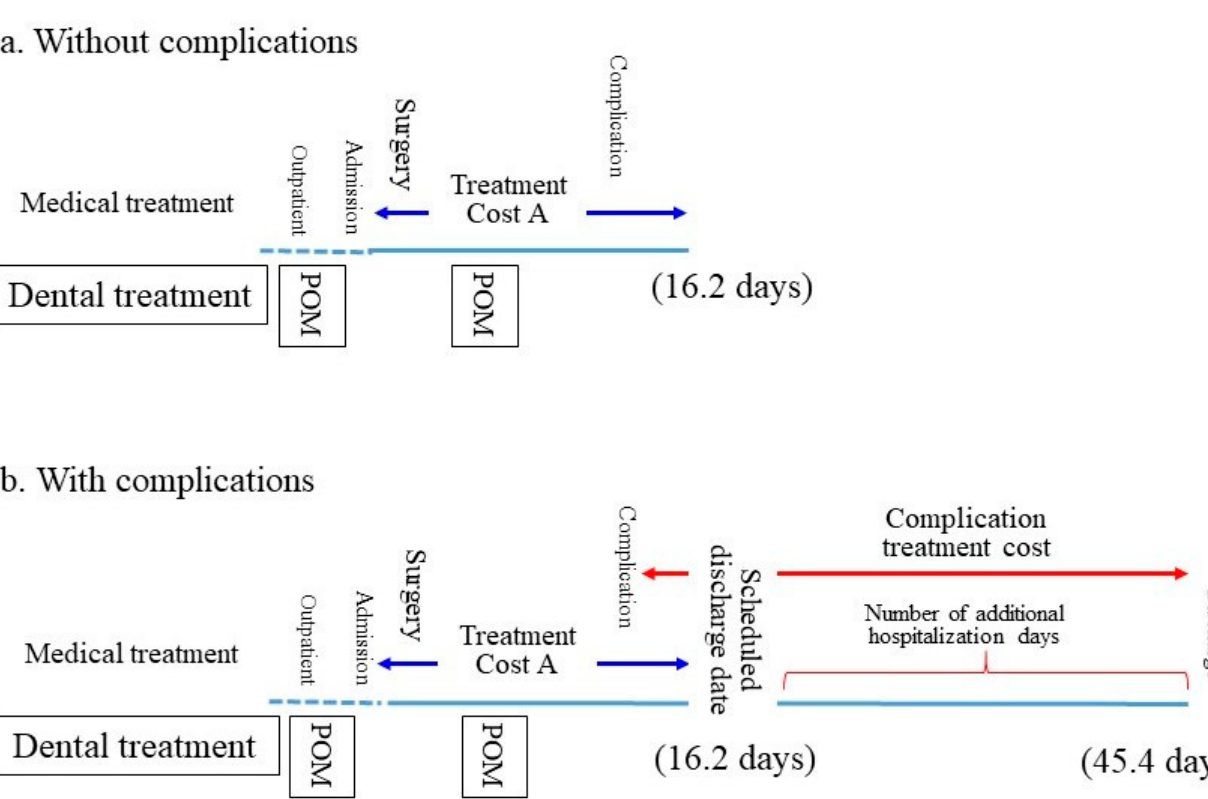
Figure 2. Differences in the duration of hospitalization and costs depending on the presence of complications. Numbers are the actual numbers of days of hospitalization after the introduction of perioperative oral management (POM). Dashed line shows preoperative dental treatment, blue line shows postoperative dental treatment, the range shown in dark blue represents treatment cost A (Treatment Cost A; Cancer-related treatment cost + Treatment cost for comorbidities). The range shown in red line represents treatment cost generated by complication.